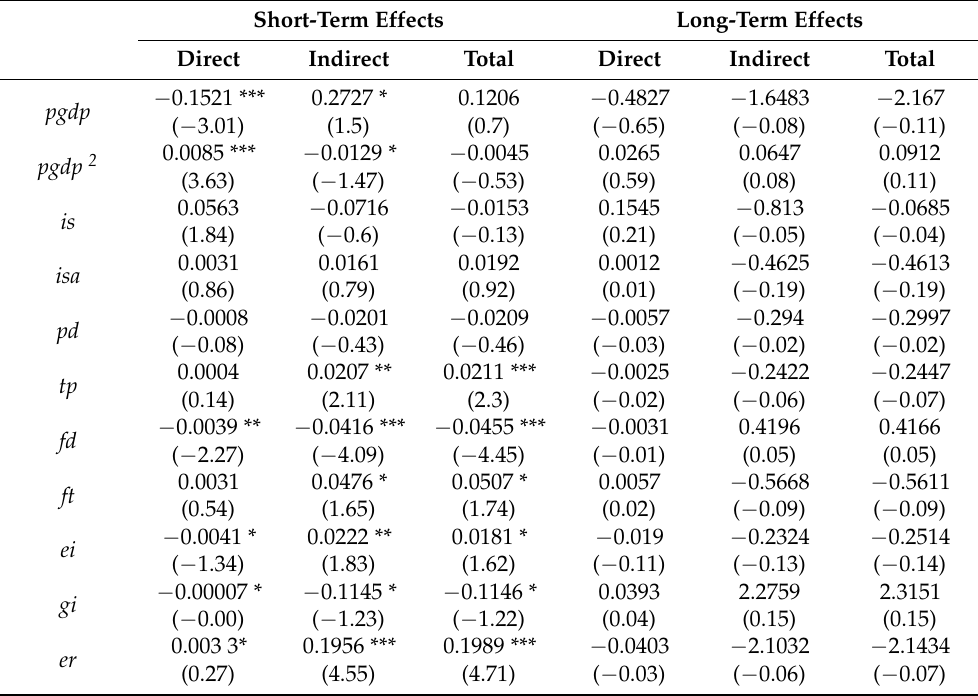
Table 4. Direct, indirect, and total